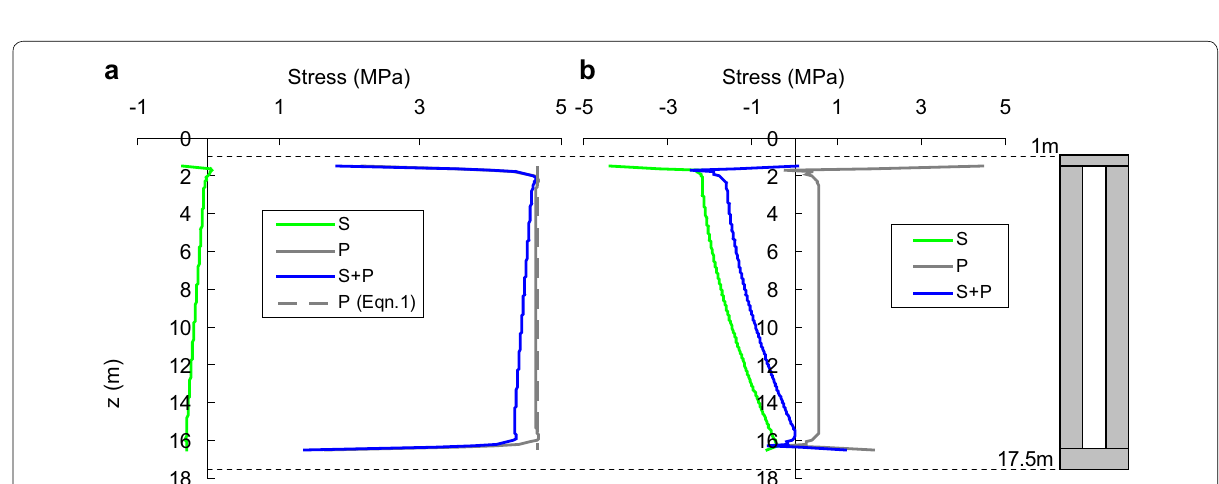
Fig. 9 Stress distributions along the longitudinal direction at inner surface: a circumferential stress; b vertical